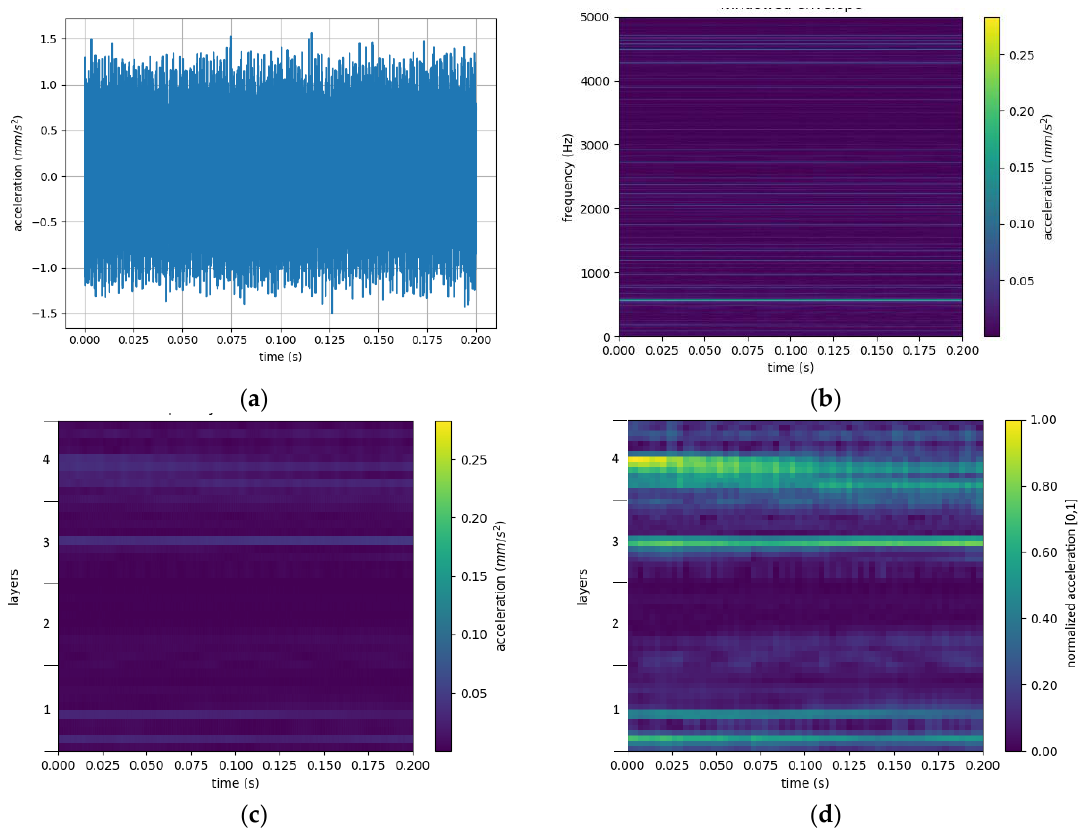
Figure 4. The steps of the intermediate domain creation: ( a ) raw sensor data; ( b ) windowed envelope; ( c ) the frequency selective filter; ( d ) final intermedia domain image (after normalization and scaling). The layers in ( c , d ) correspond to the following fault areas of a bearing: 1: outer; 2: inner; 3: ball; 4: cage.